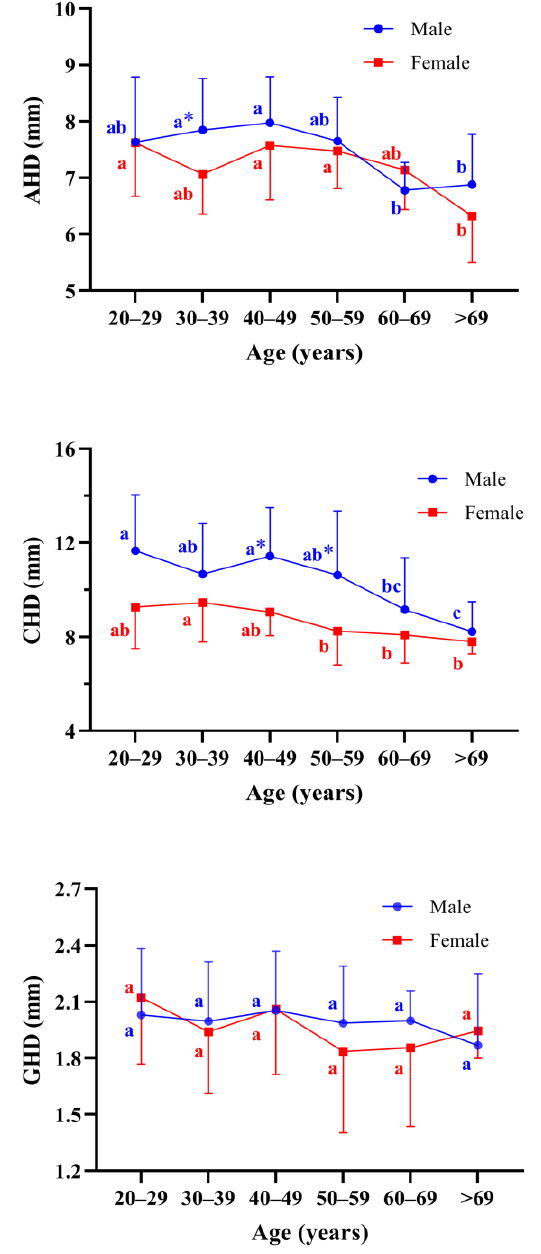
Figure 5. Statistical relationships among ages in both sex and statistical comparation between sexes for AHD, CHD, and GHD. a, b, and c indicate the letter marking method for the comparison between each age group within the group. * Indicates a significant difference in the comparison of the receiving female group p < 0.05. AHD acromiohumeral distance, CHD coracohumeral interval, GHD glenohumeral distance.